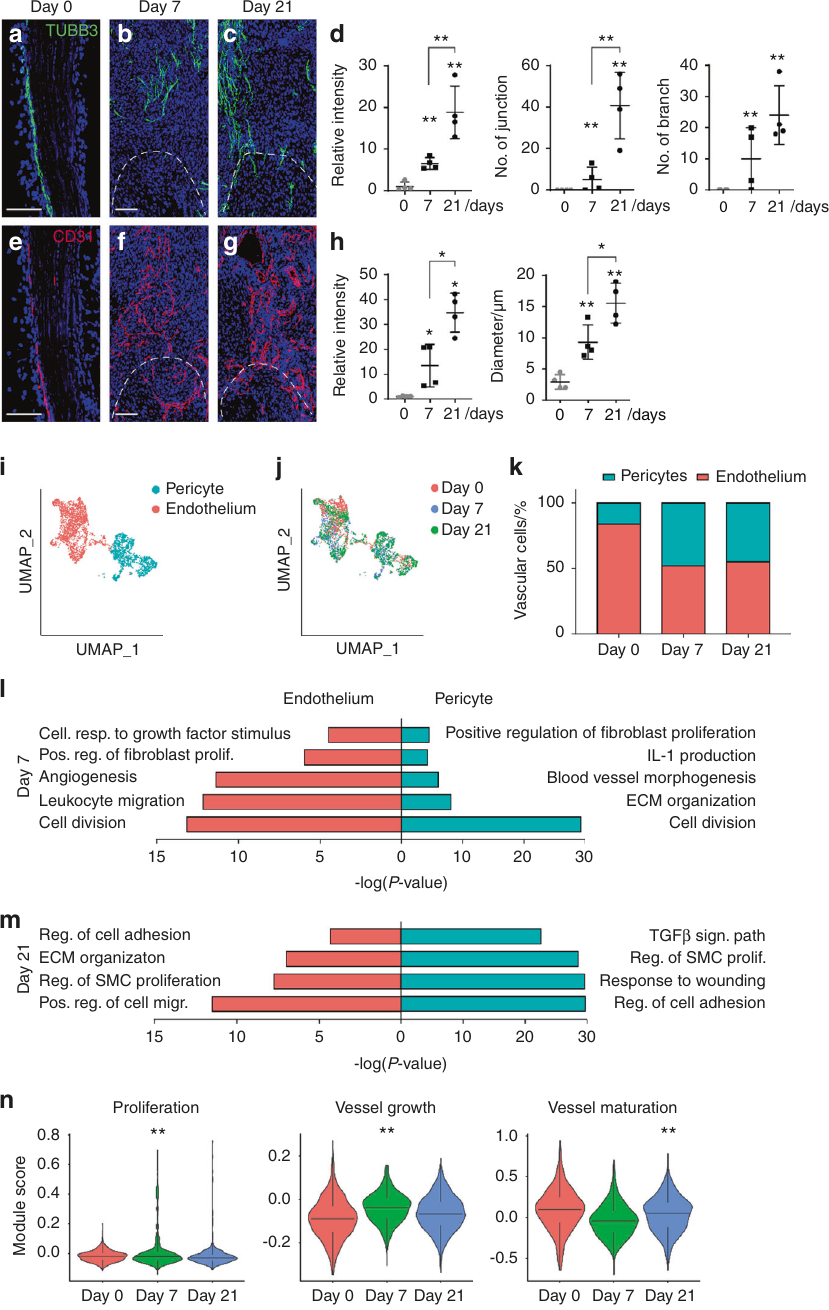
Fig. 1 Neurovascular ingrowth and transcriptional pro fi le after soft tissue trauma. Traumatic injury (complete Achilles tenotomy with dorsal burn to induce heterotopic ossi fi cation) was performed on 6 – 8 weeks old, male and female C57BL/6 J mice, with analyses at 7 and 21 days. Day 0 indicates uninjured control. a – c Representative pan-neuronal Beta III Tubulin (TUBB3) immuno fl uorescent staining within sagittal sections of tendon injury site, day 0, 7 and 21 post-tenotomy. d Quanti fi cation of TUBB3 + nerves within the injury site over time, including overall TUBB3 staining intensity, number of nerve junctions, and number of nerve branches. e – g Representative immuno fl uorescent staining of the endothelial marker CD31 over the 21-day time course post-injury. h Quanti fi cation of CD31 + blood vessels within the injury site over time, including overall CD31 staining intensity and vessel diameter. i – m Single cell RNA sequencing analysis of pooled cells from the injury site, obtained at day 0, 7 and 21 post-injury. i UMAP visualization of endothelial and pericyte clusters at all timepoints, and ( j ) UMAP visualization indicating cells at day 0, 7 and 21 post-injury. k Percentage of endothelial cells and pericytes across time as a function of both cell types combined. l, m GO term analysis of endothelial cells (red) and pericytes (blue) at day 7 and day 21 post injury in relation to uninjured control. n Modular index scoring of cell proliferation, vessel growth, and vessel maturation in endothelial cells across time points. Gene lists for modular scores are shown in File S1. Dashed white lines indicate edges of Achilles tendon. Scale bars: 100 μ m. For histology, n = 4 animals per timepoint. For scRNA-Seq, n = 3 animals per timepoint. Individual dots in scatterplots represent values from single animal measurements, while mean and one SD are indicated by crosshairs and whiskers. * P < 0.05; ** P < 0.01 in relation to D 0 timepoint. Two-tailed student ’ s t test was used for two-group comparisons ( b , d ). For more than two groups, one-way ANOVA followed by post hoc analysis was performed ( n ). Non-parametric data was analyzed using the Kruskal – wallis with Dunn ’ s multiple comparison test ( n